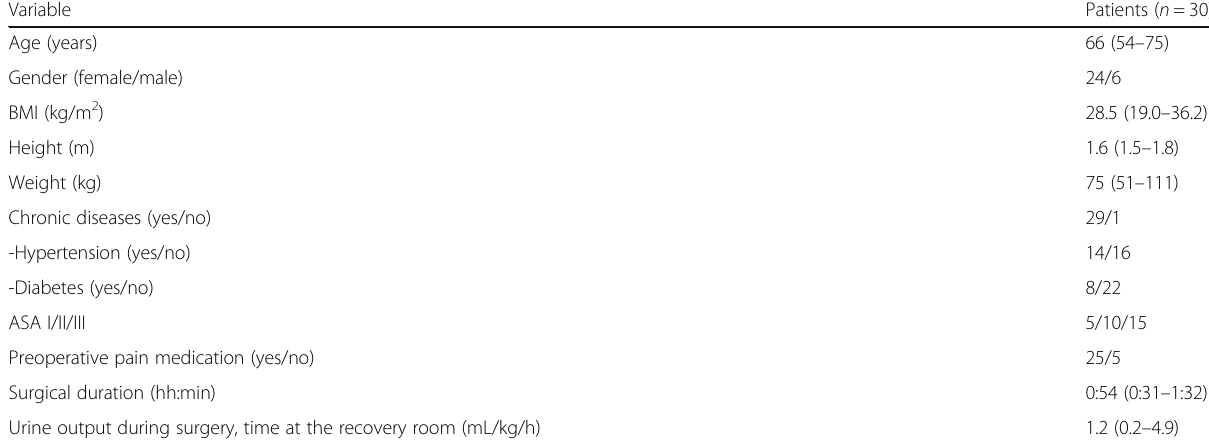
Table 2 Patients ’ characteristics, data are presented as median and (minimum-maximum) or number of cases